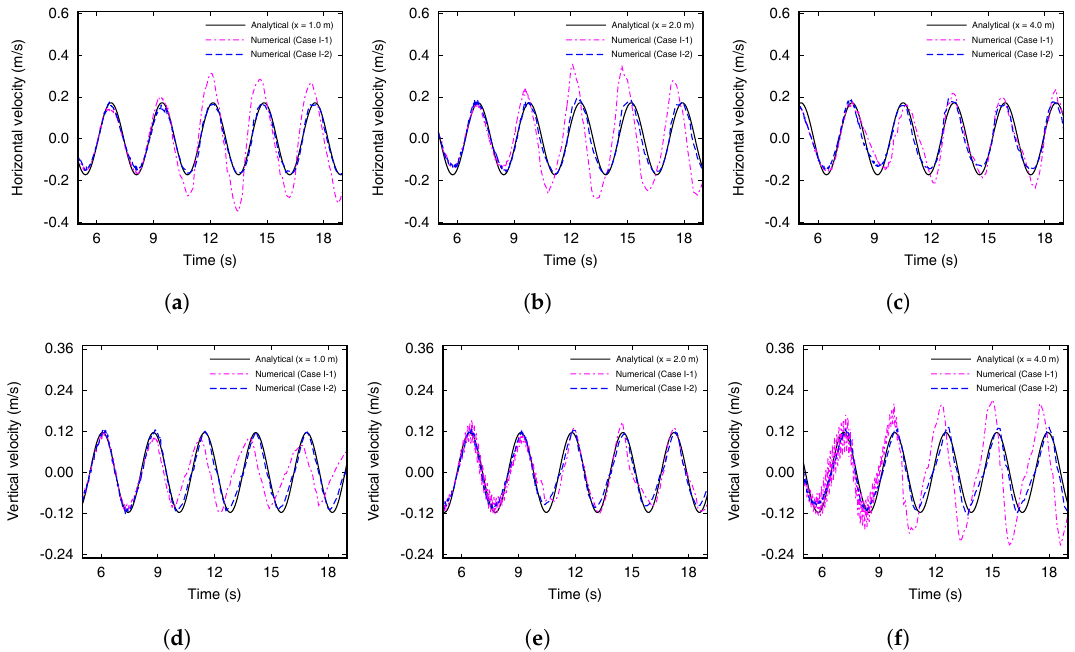
Figure 5. Comparison of the numerical and analytical results of horizontal velocities ( a ) at x = 1.0 m, ( b ) x = 2.0 m, and ( c ) x = 4.0 m. Results of vertical velocities ( d ) at x = 1.0 m, ( e ) x = 2.0 m, and ( f ) x = 4.0